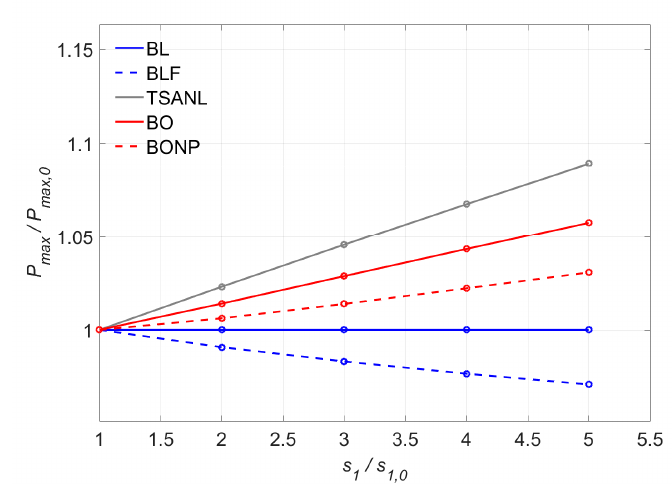
Figure 17. Variation of P max versus s 1 .